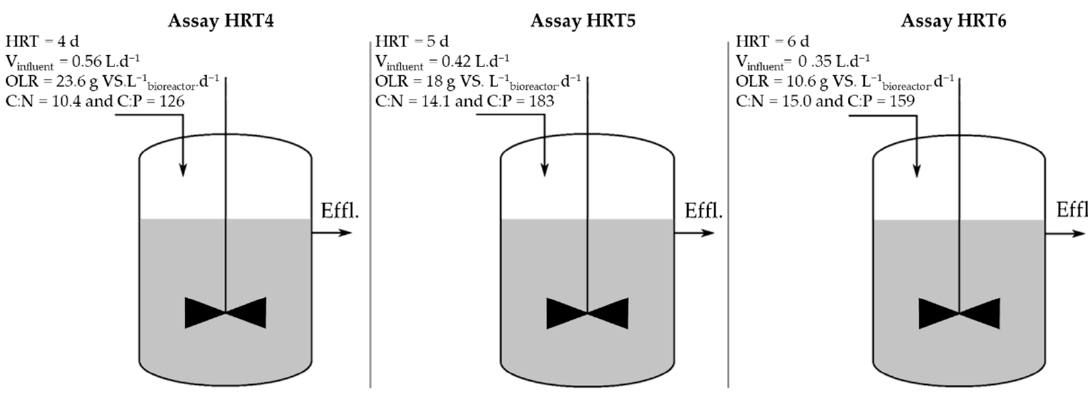
Figure 3. Global overview of the operational parameters in the HRT4, HRT5, and HRT6 assays.